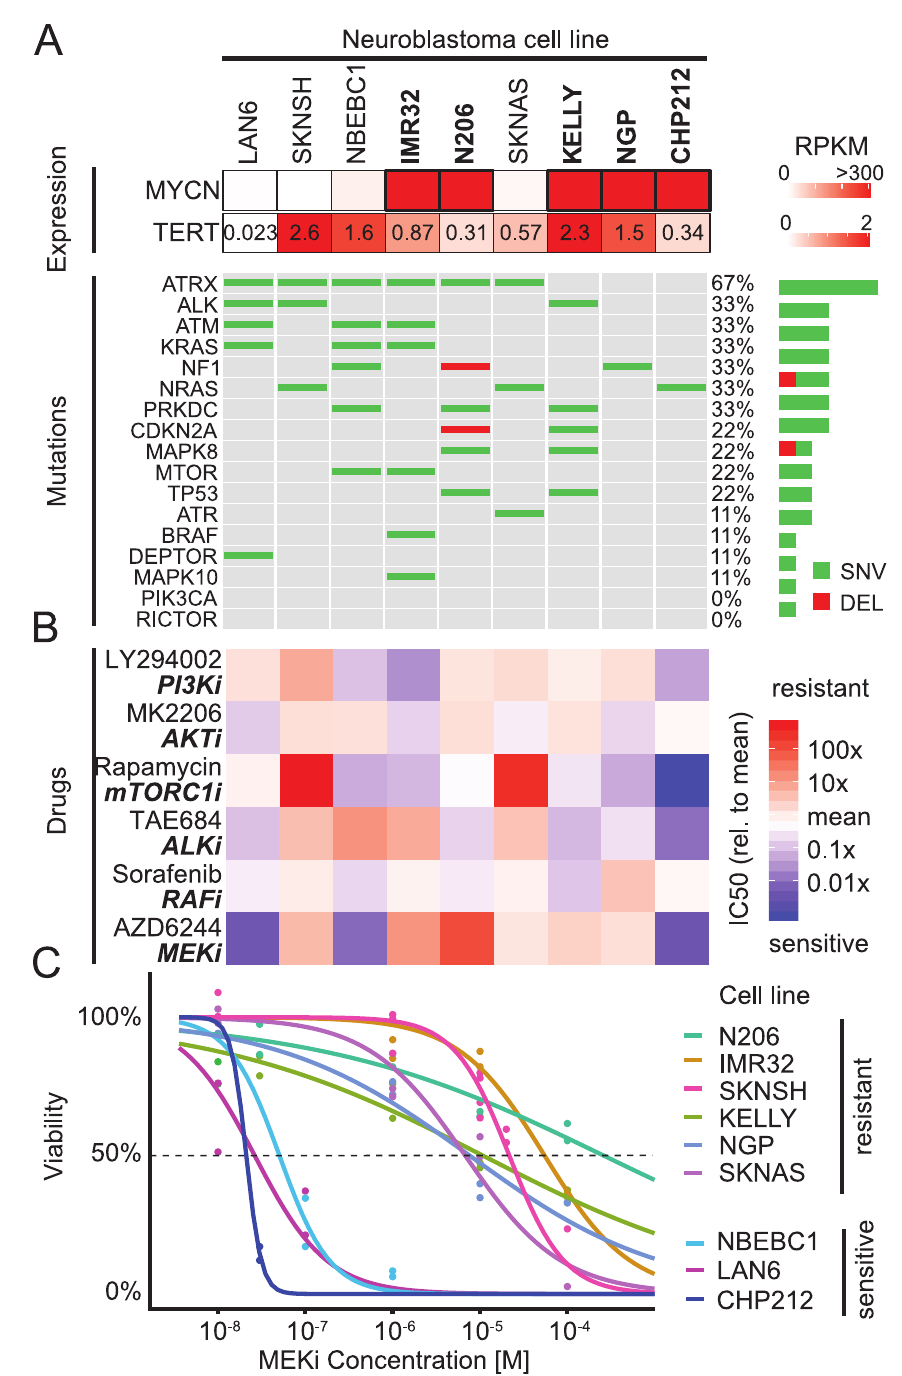
Fig 1. Mutations are insufficient to explain sensitivity variations to RAS/PI3K drugs in neuroblastoma cell line panel. A: Oncoprint of 9 neuroblastoma cell lines for RAS/p53/PI3K related genes along with MYCN and TERT mRNA expression. Bold font indicates MYCN-amplified cell lines. B: Relative IC50 of the same 9 neuroblastoma cell lines as in A for drugs targeting the PI3K and MAPK pathways (n = 2). C: Viability concentration curves for the MEK inhibitor AZD6244 on the neuroblastoma cell line panel along with the calculated IC50 (intersection with dotted line). Points represent measurements (n = 2).